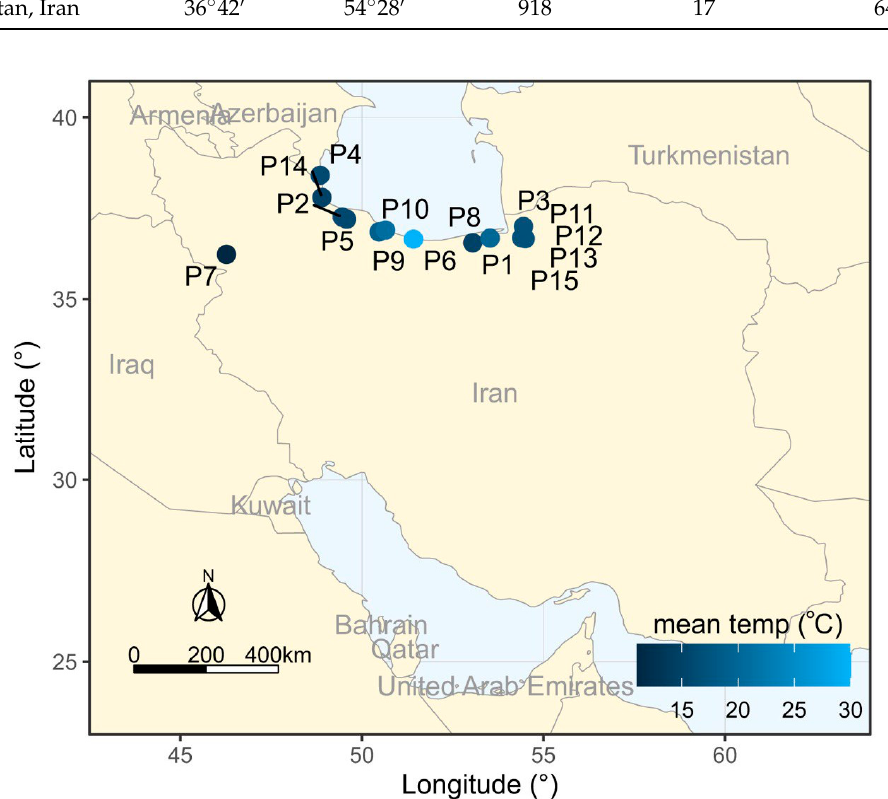
Figure 8. Location of the sampling sites of 15 Iranian endemic Hypericum perforatum L. populations on the map of Iran, using ArcGIS.